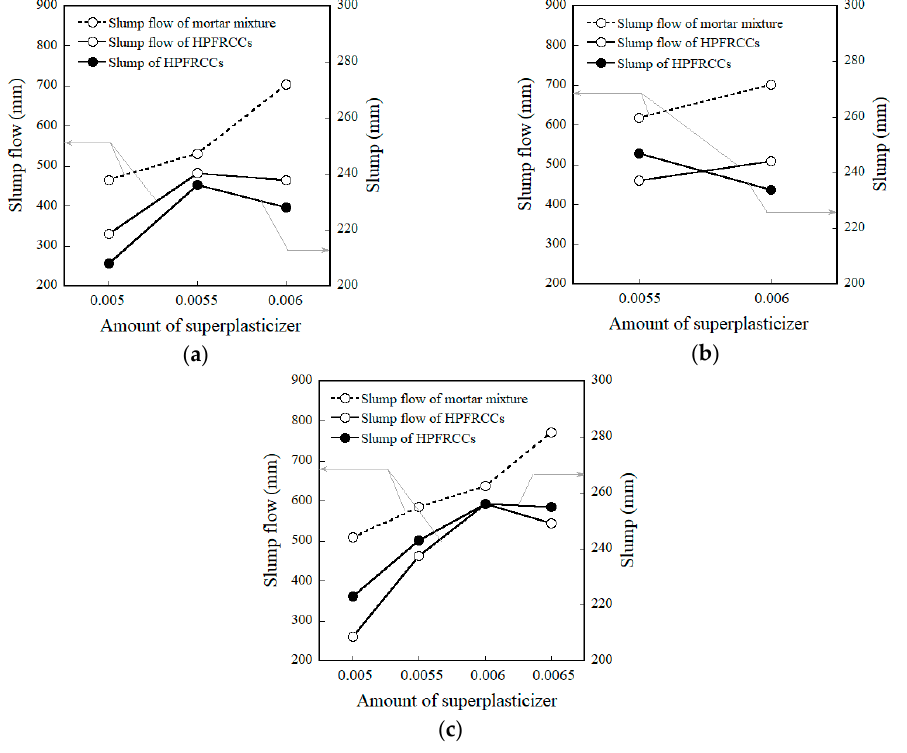
Figure 6. Effects of adding MGFs on the flowability of mortar and HPFRCCs: ( a ) M0.00, ( b ) M0.05, and ( c ) M0.10.